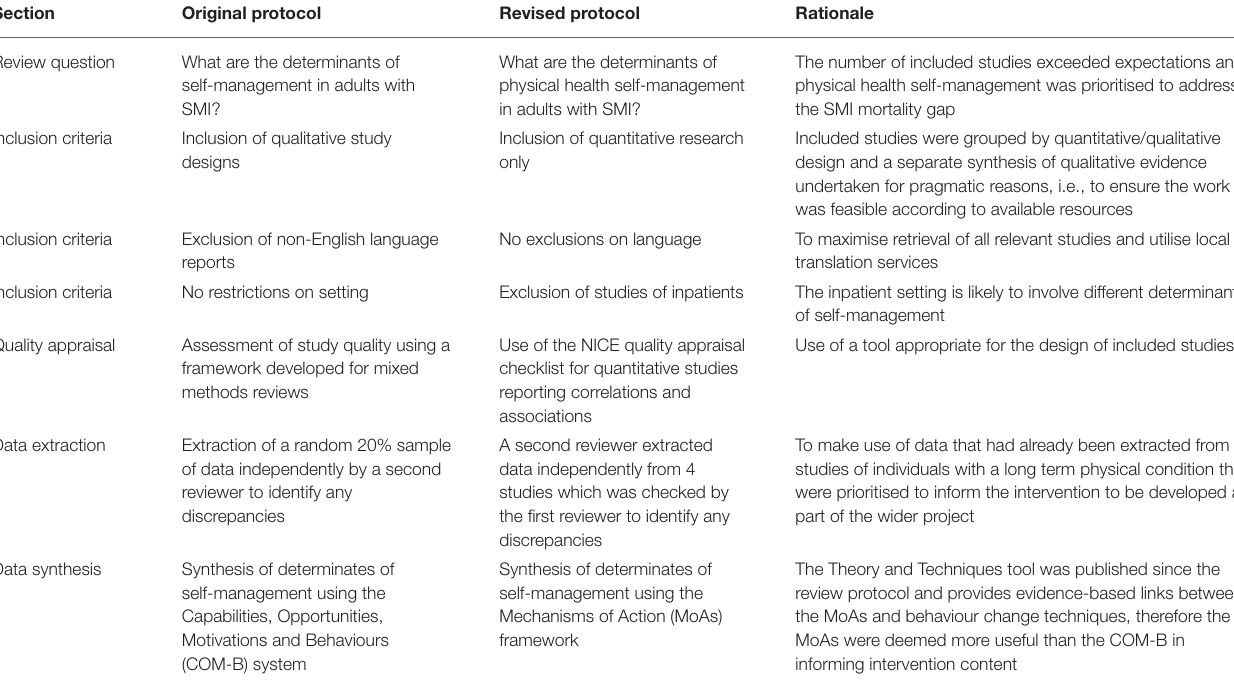
TABLE 1 | Amendments to